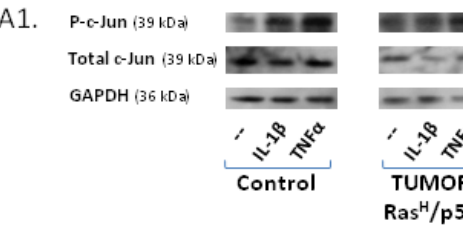
Figure 5. TUMOR-Ras H /p53 L cells are highly responsive to inflammatory stimulation, as indicated by AP-1 activation. ( A ) AP-1 activation was determined by analyzing c-Jun phosphorylation levels in TUMOR-Ras H /p53 L cells and in control cells (in which the expression of Ras and p53 was not modified), prior and following stimulation by IL-1 β (500 pg/mL) or TNF (50 ng/mL) for 24 h, by Western blot analysis. ( A1 ) Western blots showing c-Jun phosphorylation, total c-Jun levels and GAPDH levels as a loading control. A representative experiment of n = 2 is presented. ( A2 ) Densitometry values of control cells, prior or after stimulation by the cytokines. Non-stimulated cells were given the value of 1. ( A3 ) Densitometry values of TUMOR-Ras H /p53 L cells, prior or after stimulation by the cytokines. Non-stimulated cells were given the value of 1. In ( A2 ) and ( A3 ), relative AP-1 activation levels were calculated as described in the “Experimental Section” (phosphorylated c-Jun/total c-Jun/GAPDH) and the results presented are the average ± SD of densitometry levels obtained in 2 experiments. ( B ) Relative levels of c-Jun phosphorylation induced by IL-1 β or TNF in control cells, in comparison to TUMOR-Ras H /p53 L cells. The values were obtained by comparison of the densitometry values of cells (control or TUMOR-Ras H /p53 L ) treated by the cytokines, to non-stimulated control cells, that were given the value of 1 (the control cells are not shown in the Figure). The results are the average ± SD of activation levels obtained in 2 experiments. ( C ) TUMOR-Ras H /p53 L cells were transfected with (1) construct of firefly luciferase under the control of AP-1 binding sites, and (2) construct of renilla luciferase. The cells were either not stimulated or stimulated with IL-1 β (500 pg/mL, 6–8 h) or TNF (50 ng/mL, 8 h). Time points were selected based on preliminary kinetics analysis. Luciferase AP-1 activation levels relative to renilla luciferase in non-stimulated cells were given the value 1. A representative experiment of n = 3 is